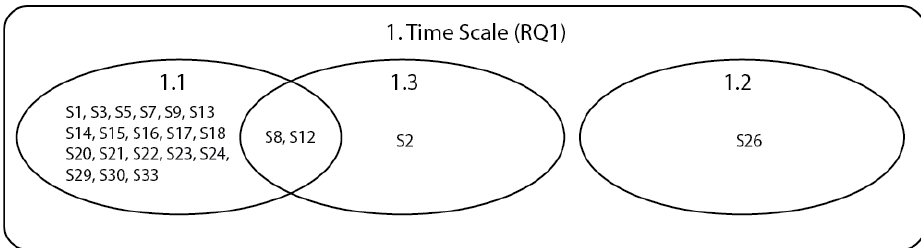
Figure 5. Types of time scale ( RQ1